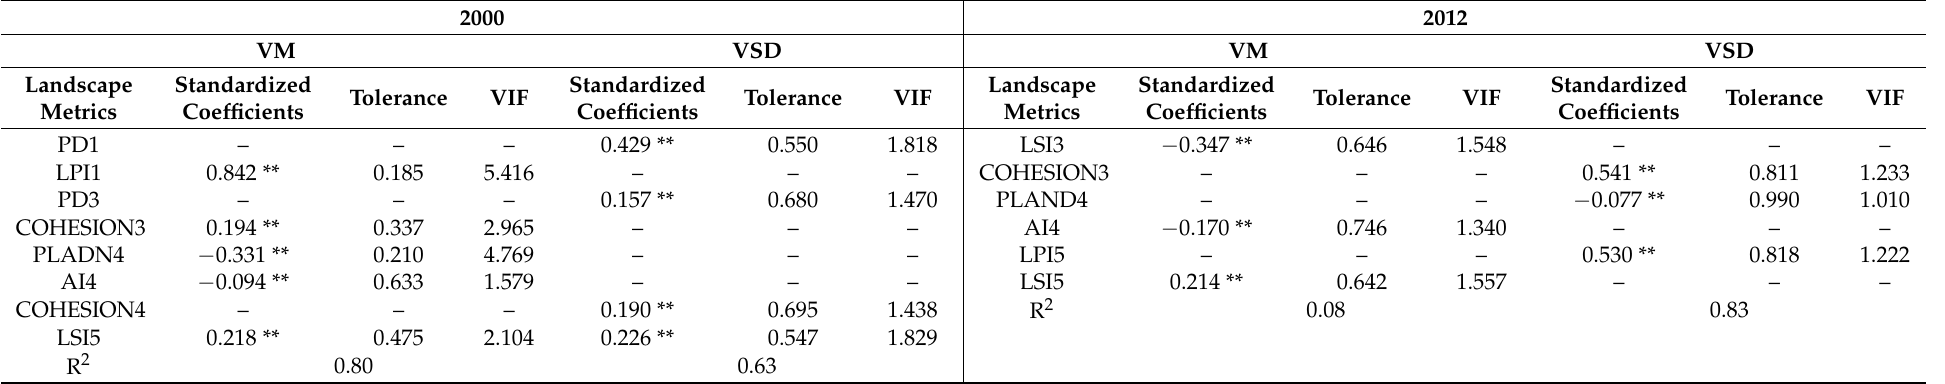
Table A5. SLR parameters of VM, VSD and class-level landscape metrics in residential